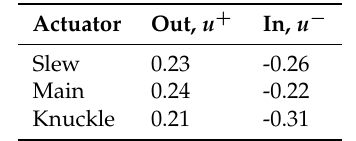
Table 5. Deadband for each